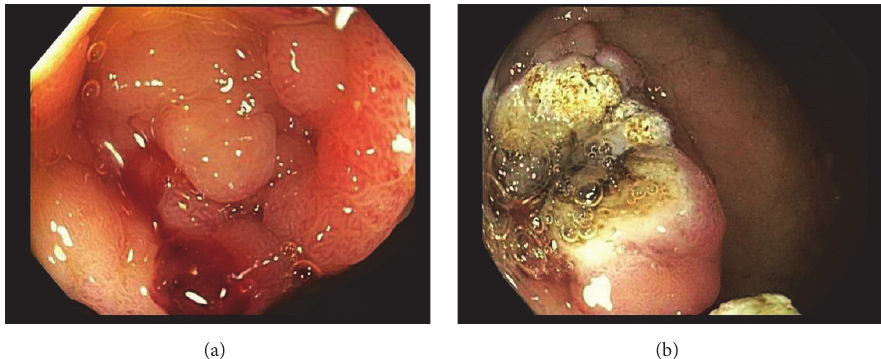
Figure 3: Small bowel push enteroscopy: gastric heterotopia in duodenal bulb with overlying oozing extra-antral GAVE (a) and duodenal mass after Argon-Plasma Coagulation (APC) was applied for successful hemostasis